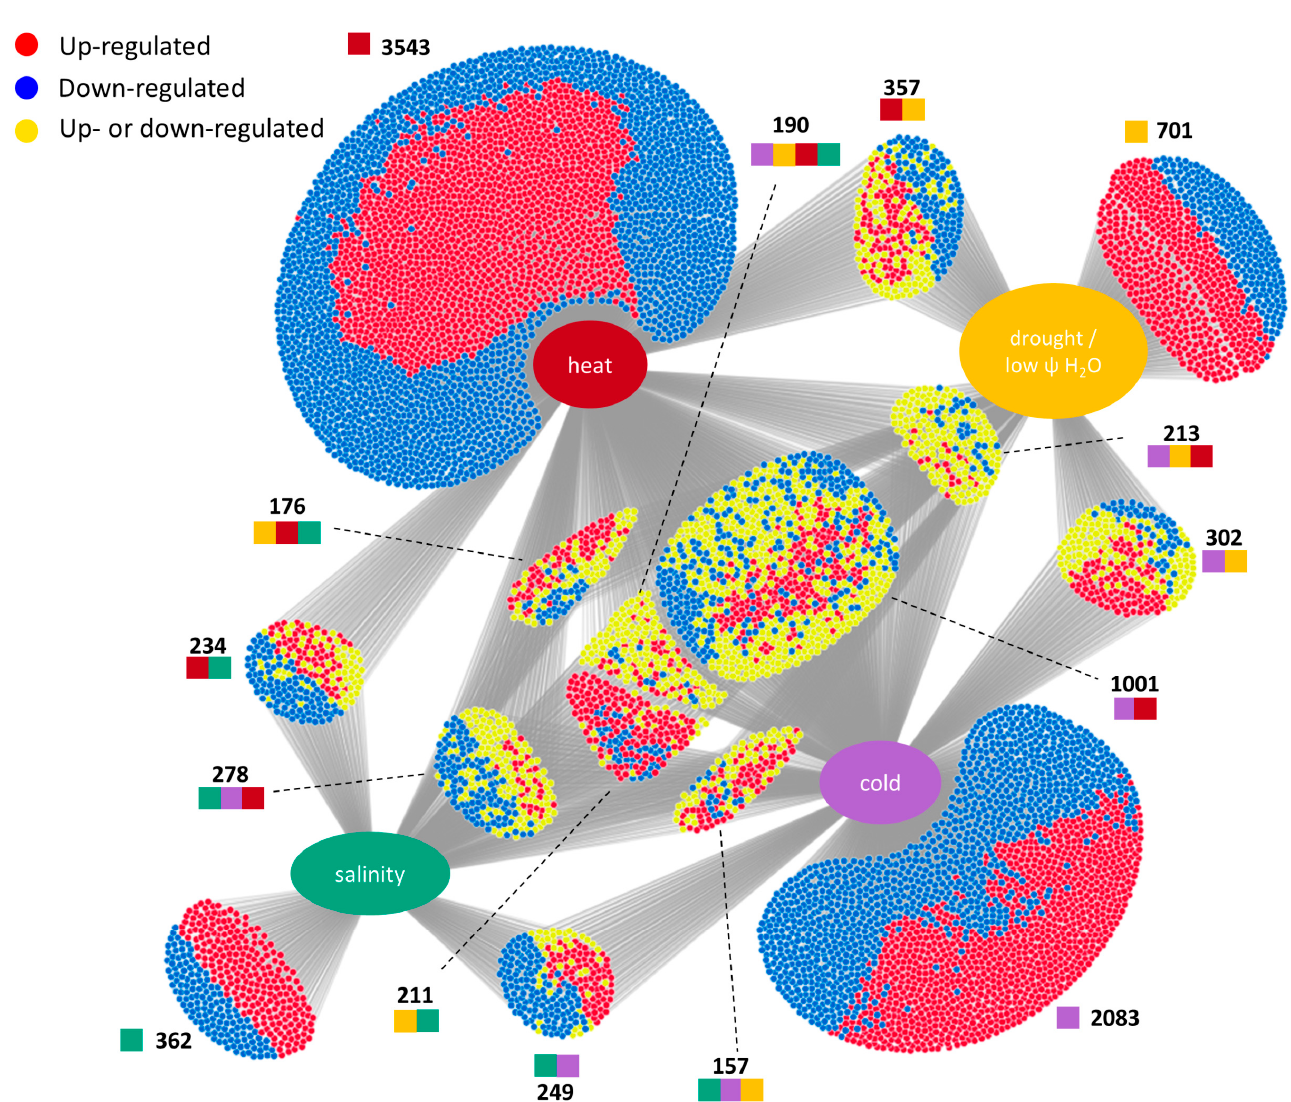
Figure 4. Visualization of groups of genes found in response to abiotic stressors. Data based on Arabidopsis expression profiles found in the Expression Atlas database [203]. Since plants are sen- sitive to stress with respect to the developmental stage, our analysis included only those works that met the following criteria: (1) involved the model plant Arabidopsis thaliana , (2) seedling stage, and (3) application of one stress. In total, the database included 11 transcriptional studies for fur- ther analyses (2 studies of heat-responsive transcriptome [204,205], 3 studies of cold-responsive transcriptome [206–208], 3 studies of drought-responsive transcriptome [209–211], and 3 studies of salt-responsive transcriptome [204,212,213]). Details of the analysis are summarized in Supplemen- tary Materials S2. Circles represent genes (red, upregulated; blue, downregulated; yellow, inverse response for different stresses). Squares represent stress treatments. Genes responsive to single abiotic stress are marked by one square, with the color corresponding to the stress (red, heat; orange, drought/low water potential; green, salinity; violet, cold). Genes responsive to several stressors are visualized by clusters marked with corresponding squares that represent all stress modulators. The image was prepared in DiVenn 1.2